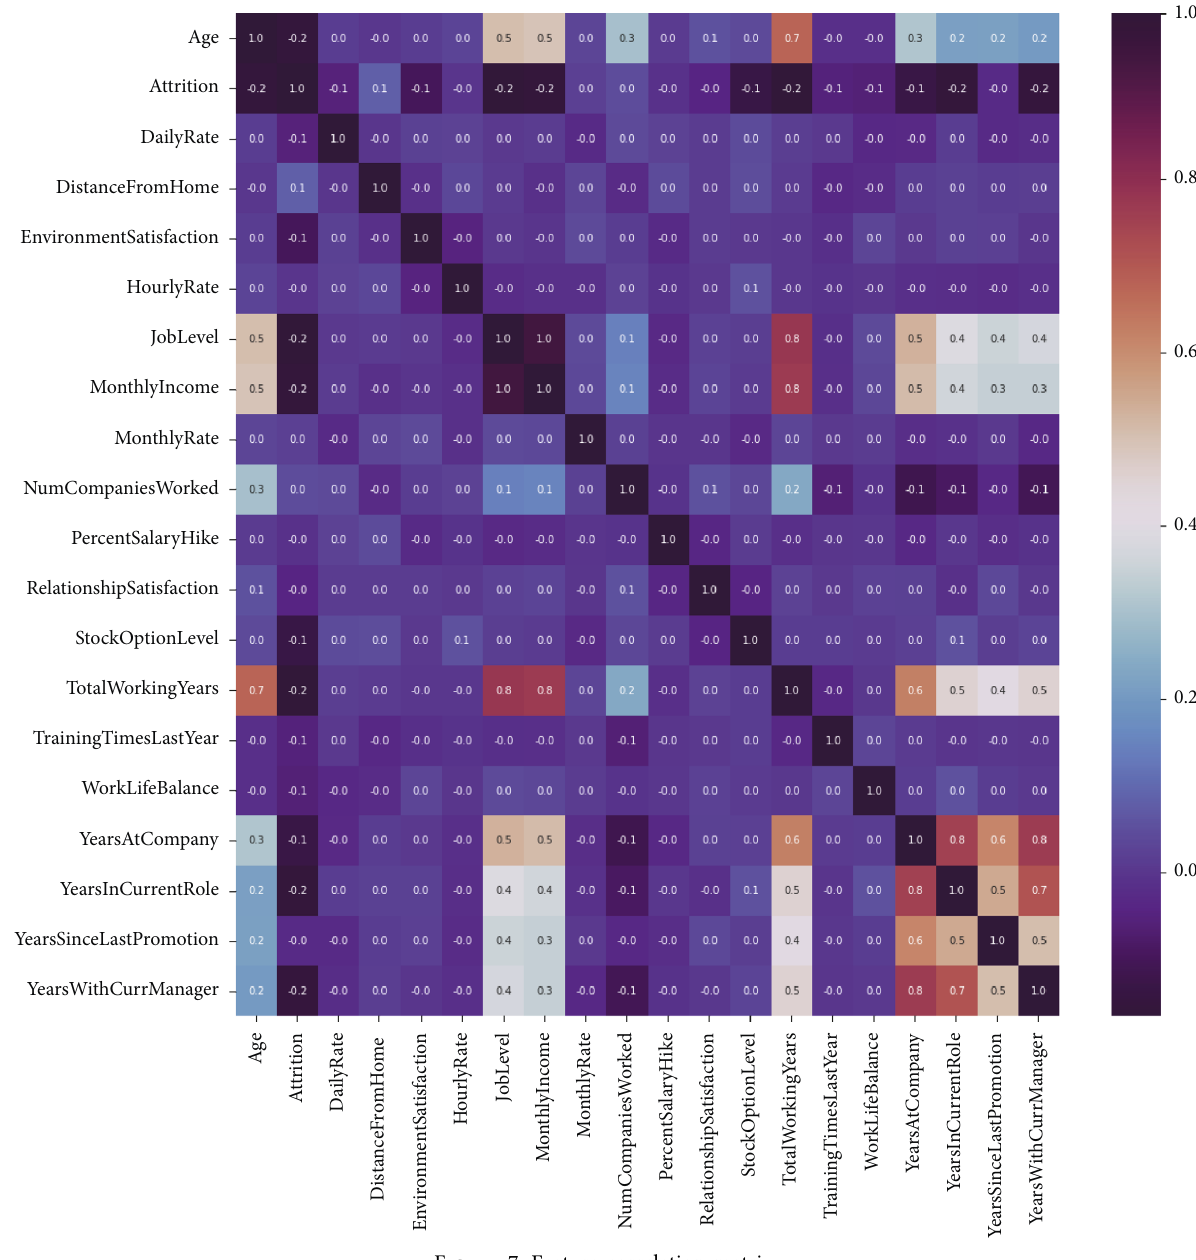
Figure 7: Feature correlation